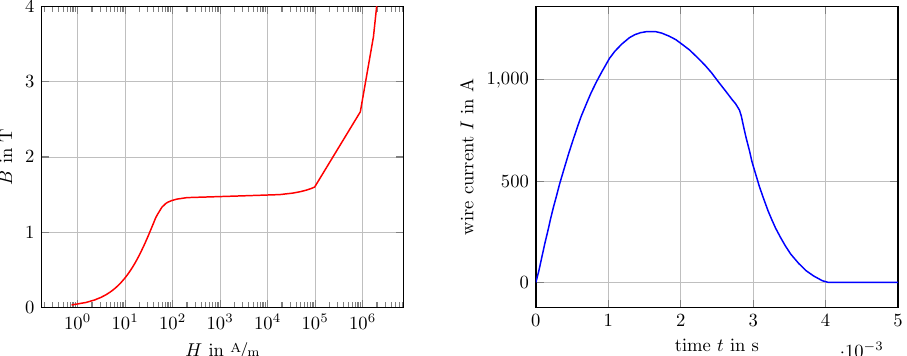
Figure 11. EM launcher input data: B ( H ) relation ( left , logarithmic H -axis), current in the wire vs. time ( right ).